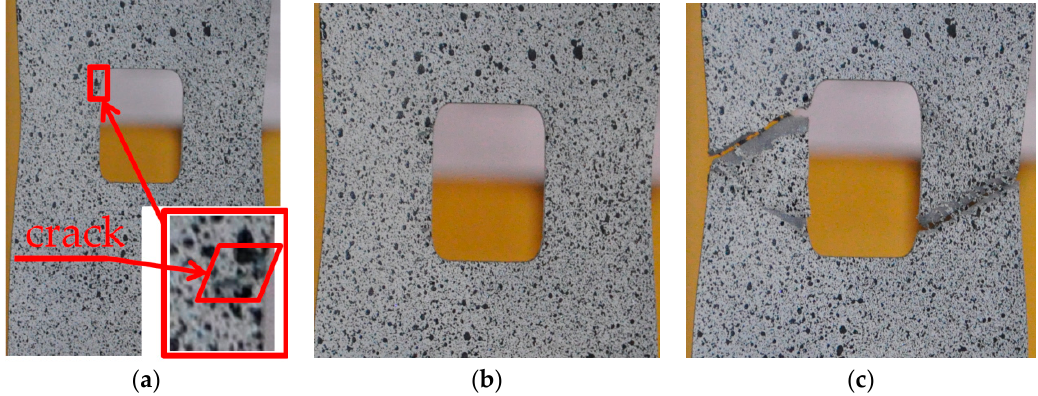
Figure 13. Tensile behavior of plate with square hole made of S235JR + N: ( a ) Point 5 with magnified zone with crack; ( b ) Point 6; and ( c ) failure. The points are given in Figure 12.